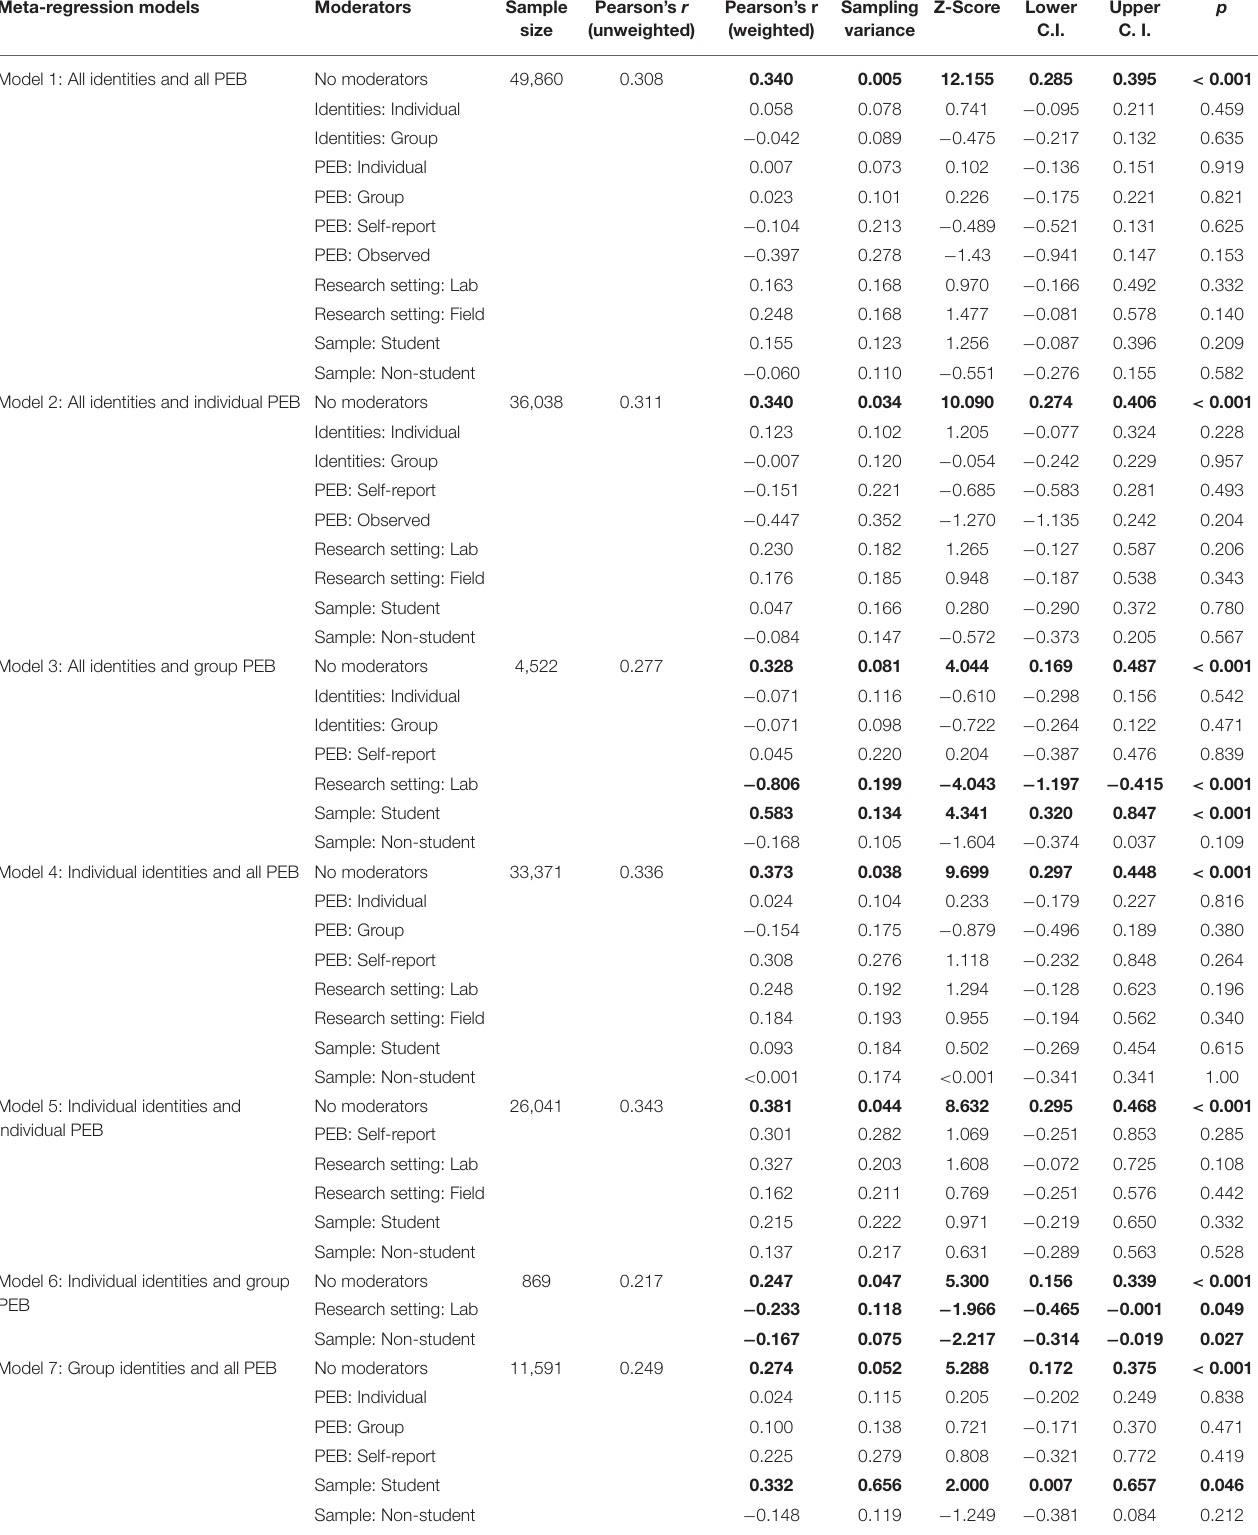
TABLE 3 | Moderator analyses of studies using identities in PEB. Meta-regression models Moderators Sample